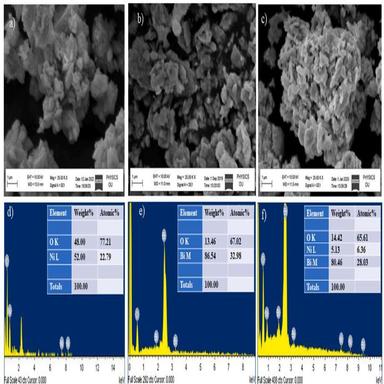
FESEM and EDX images of a), d) pure NiO; b), e) pure Bi2O3 and c), f) NBO composite materials.